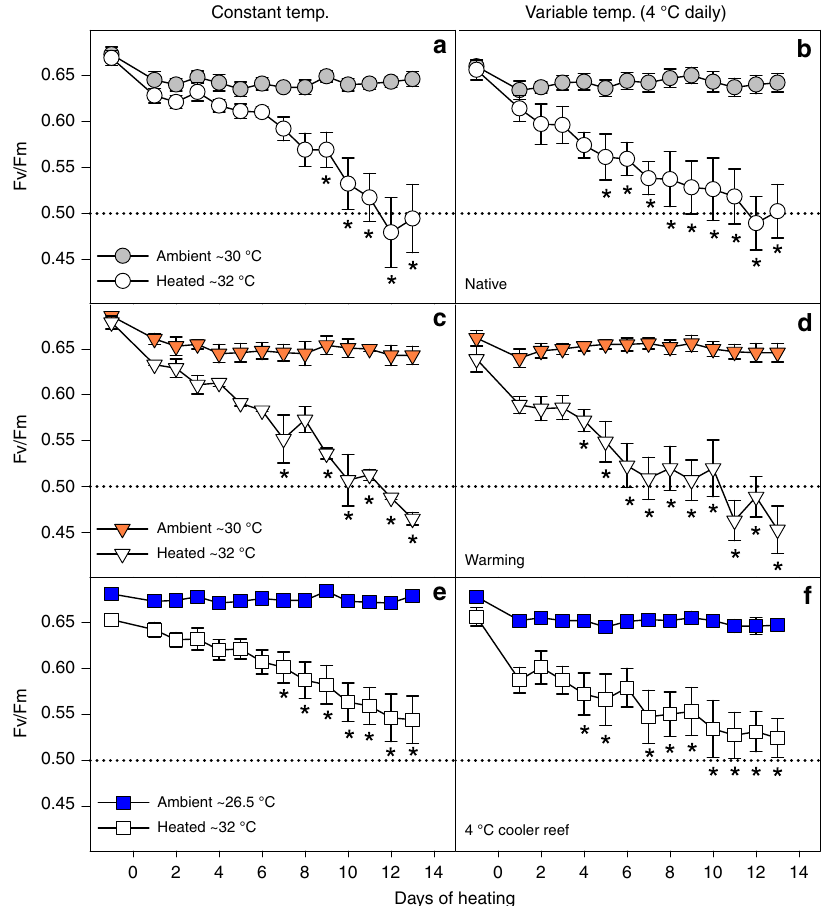
Fig. 5 Photochemical ef fi ciency (Fv/Fm) during the heat stress test. Acropora aspera corals were maintained under a , c , e constant daily temperatures or b , d , f 4 °C daily temperature variability. The heat stress test followed long-term exposure to three different temperature regimes (native control = circles, warming = triangles, 4 °C cooler reef = squares). Mean± 1 S.E.M. is shown. Asterisks indicate a signi fi cant difference between ambient and heat-stressed corals at each temperature and variability regime ( p < 0.05; Tukey post hoc tests). The dotted lines were added to highlight differences between treatments. Note that the fi rst time point corresponds to the start of the temperature ramp up (mid-April), approximately 1 month prior to the start of the heat stress test (17 May). Source data are provided as a Source Data fi